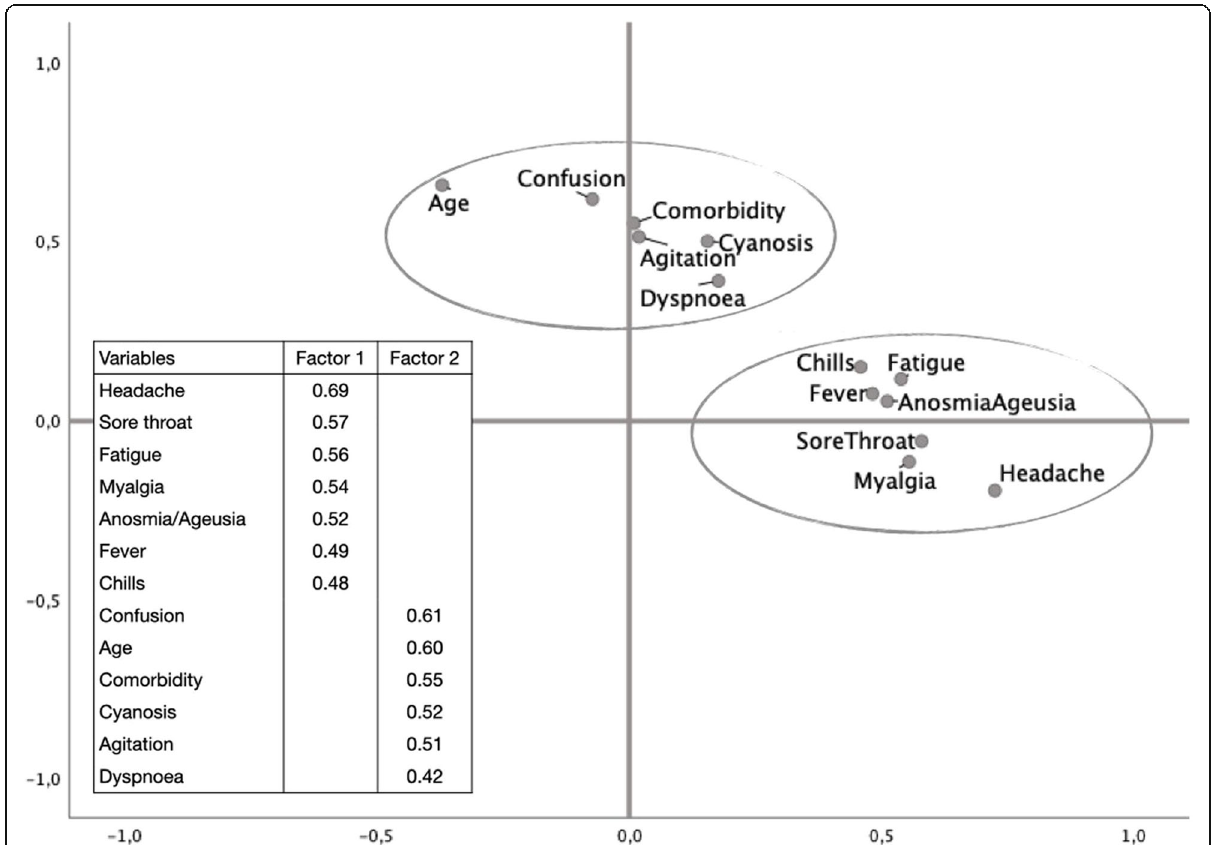
Fig. 2 Rotated factor loadings plot of each variables included in the final model (KMO measure = 0.71, Bartlett ’ s test of sphericity < 0.001; Total variance explained = 31.7%; Factor correlation =